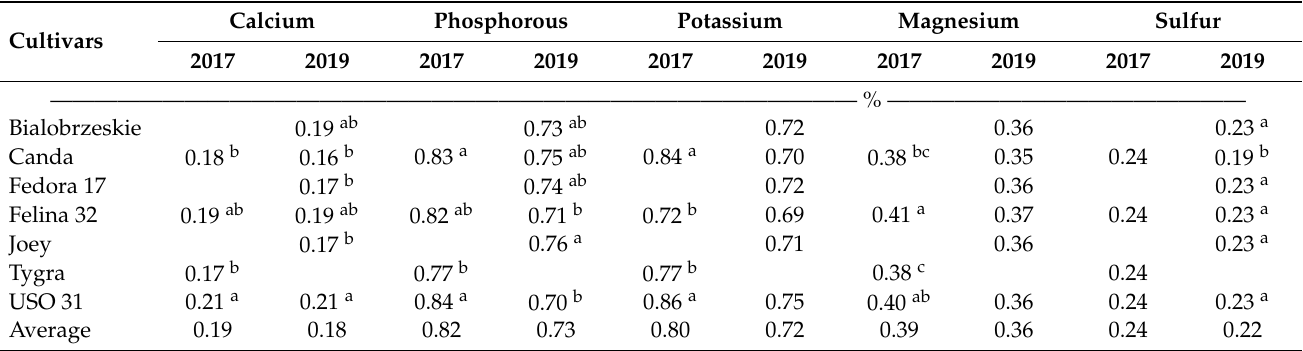
Table 5. Comparison of macronutrient element contents of hemp grain. Values are calculated means of different plant- ing dates.